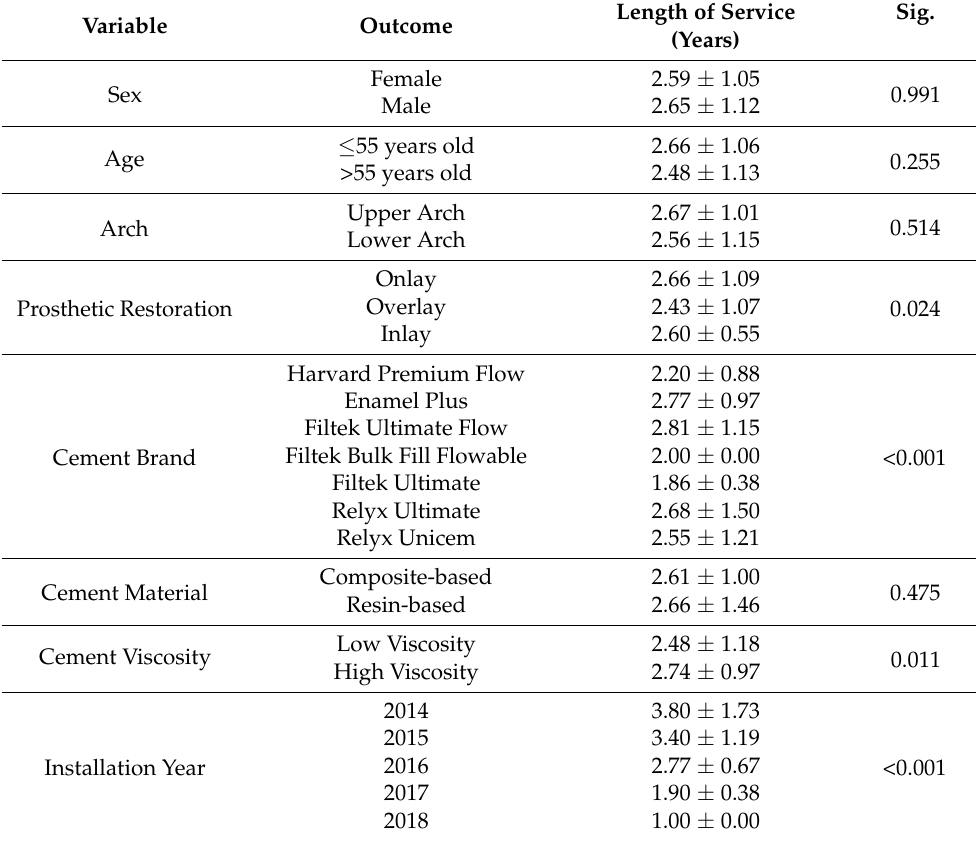
Table 3. Crude longevity of composite restorations, Palacky University Hospital, 2014–2018 ( n = 469).